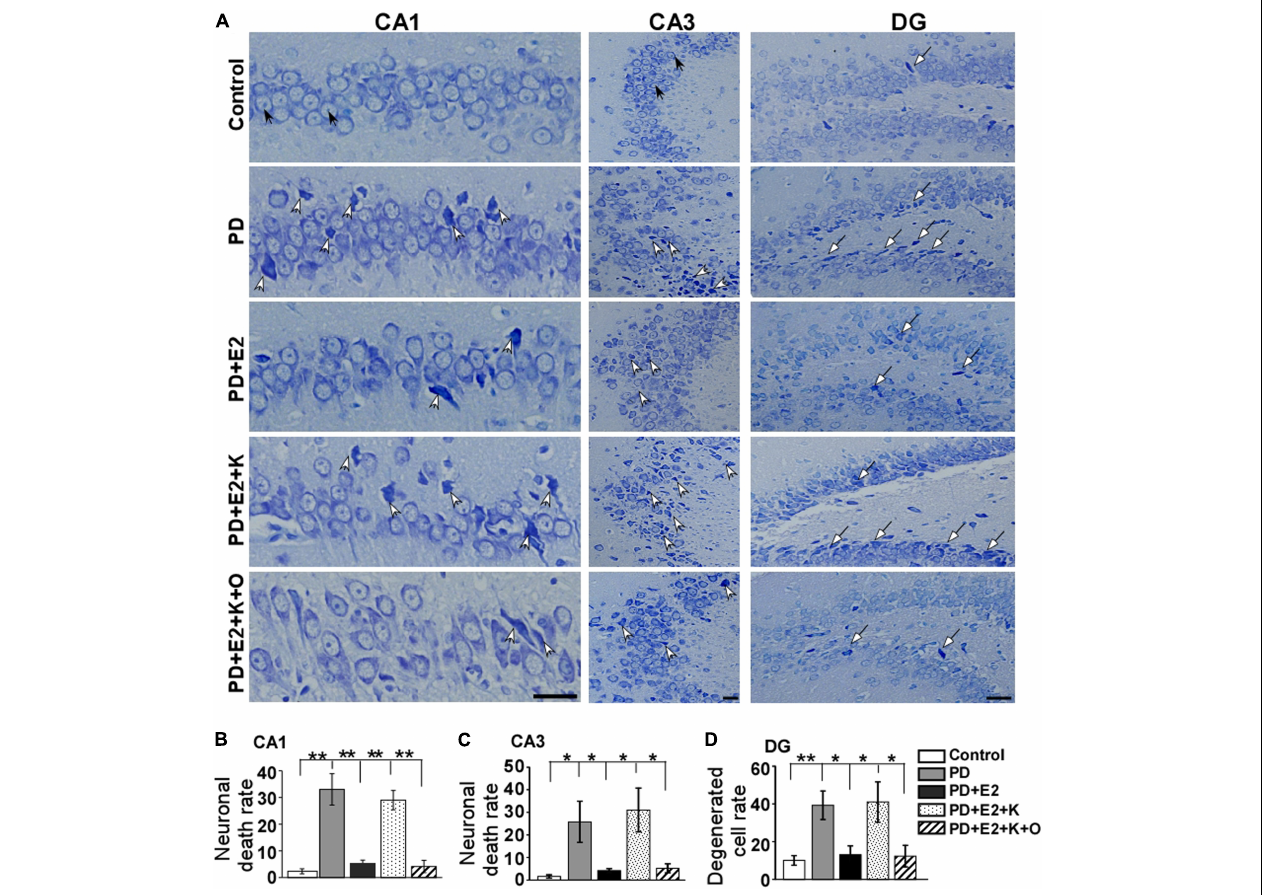
FIGURE 4 | Nissl staining showed morphological changes of neurons in the hippocampus from all experimental groups. (A) White arrows indicated destroyed neurons, black arrows indicated normal neurons and long arrows indicated degenerated dentate gyrus (DG) cells. Histograms showed the changes in neuronal death rate and degenerated cell rate in the hippocampal CA1 (B) , CA3 (C) , and DG (D) areas in all animal groups ( n = 6, each group). Results are presented as mean ± SEM. * p < 0.05; ** p < 0.01. Scale bar = 30 µ m.